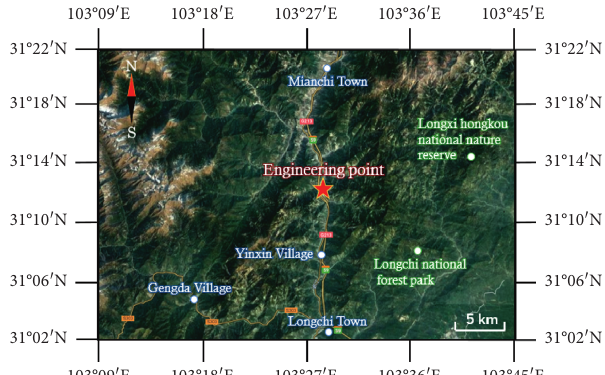
Figure 1: Location of Chediguan